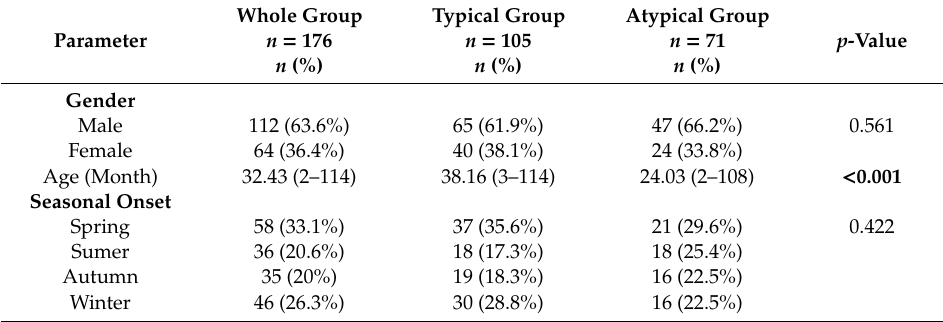
Table 1. Demographic information of typical and atypical Kawasaki disease (KD) patients.